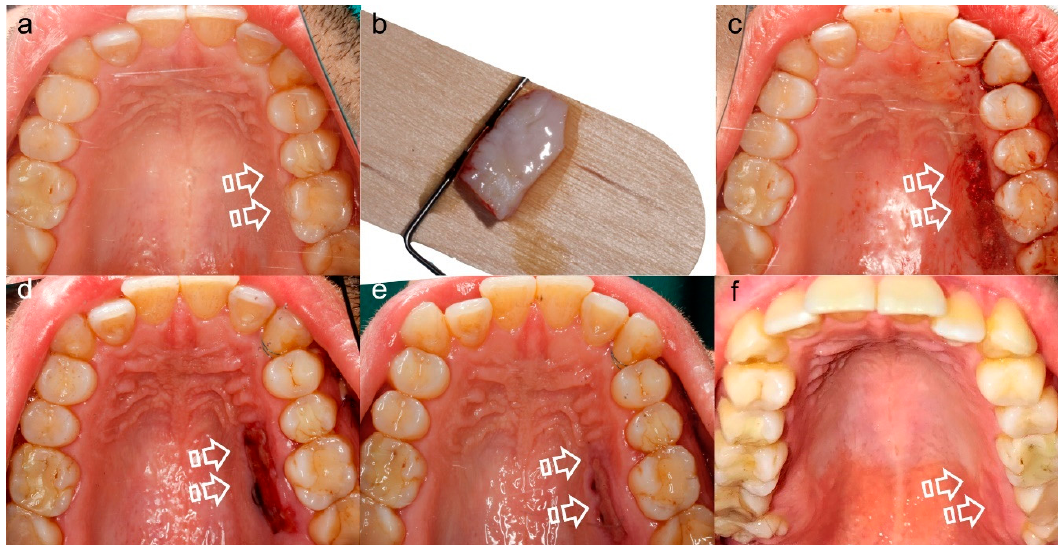
Figure 5. Palatal Wound Healing. ( a ) Prior to surgery, ( b ) harvested connective tissue graft, ( c ) post-surgery, ( d ) 7 days follow-up, ( e ) 15 days follow-up, ( f ) 21 days follow-up. This sequence of images shows the morbidity associated with the donor tissue site (arrows), that besides is scarce to supply multiple recession defects treatment.